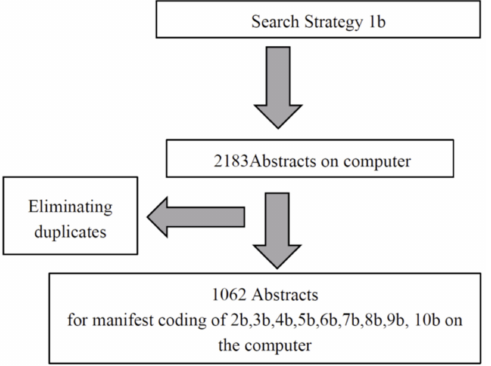
Figure 2. Search strategy for obtaining abstracts for manifest coding on the computer for the non- technical quantum